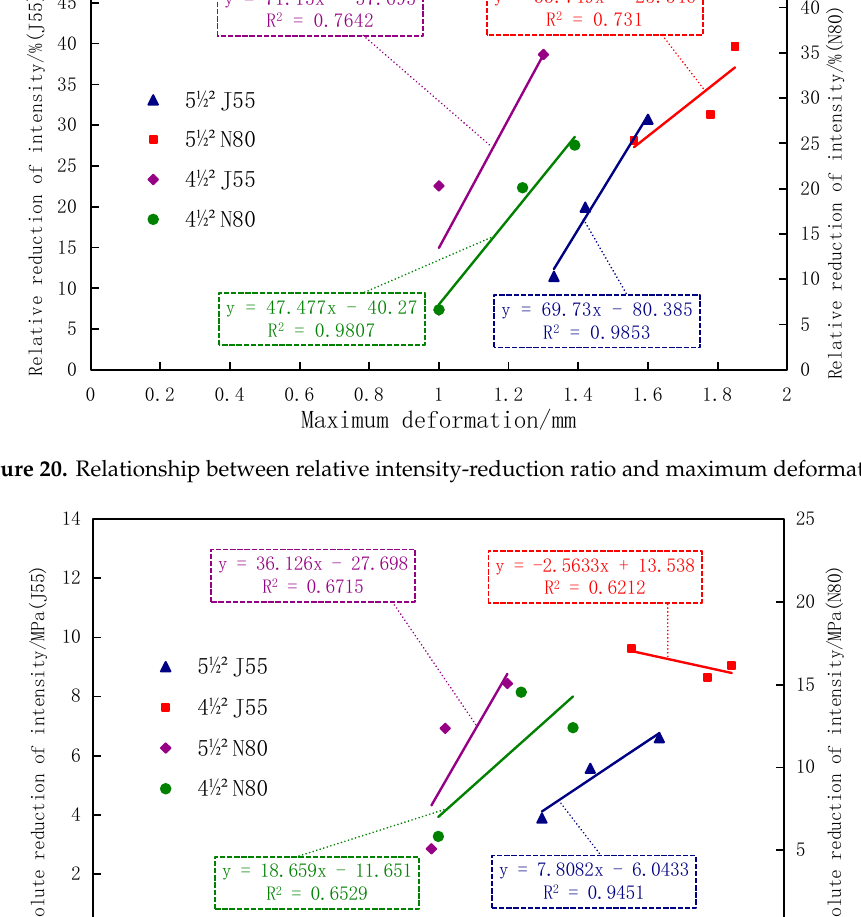
Figure 19. Relationship curve between absolute intensity-reduction value and yield stress.